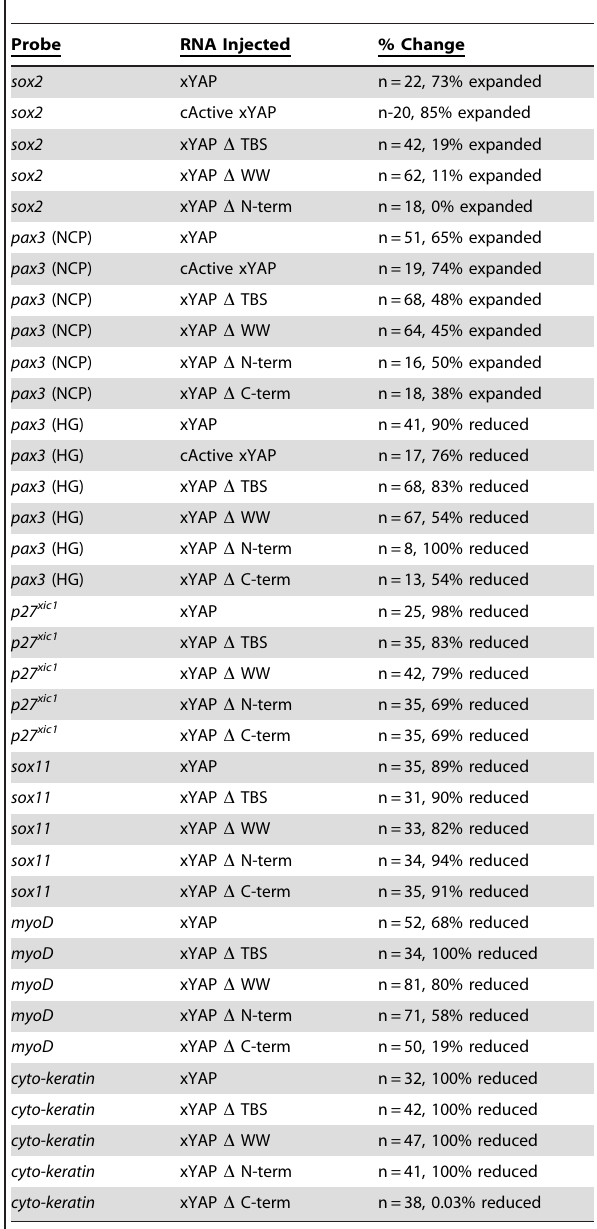
Table 1. xYAP deletion mutants exhibit differential